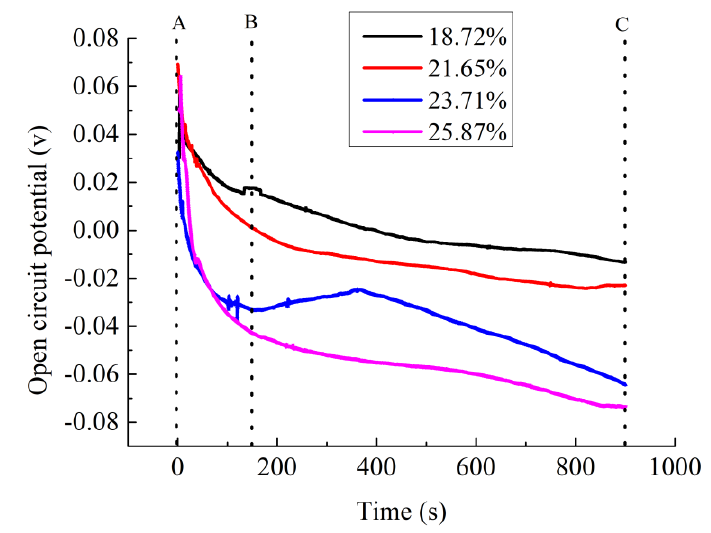
ff erent porosity